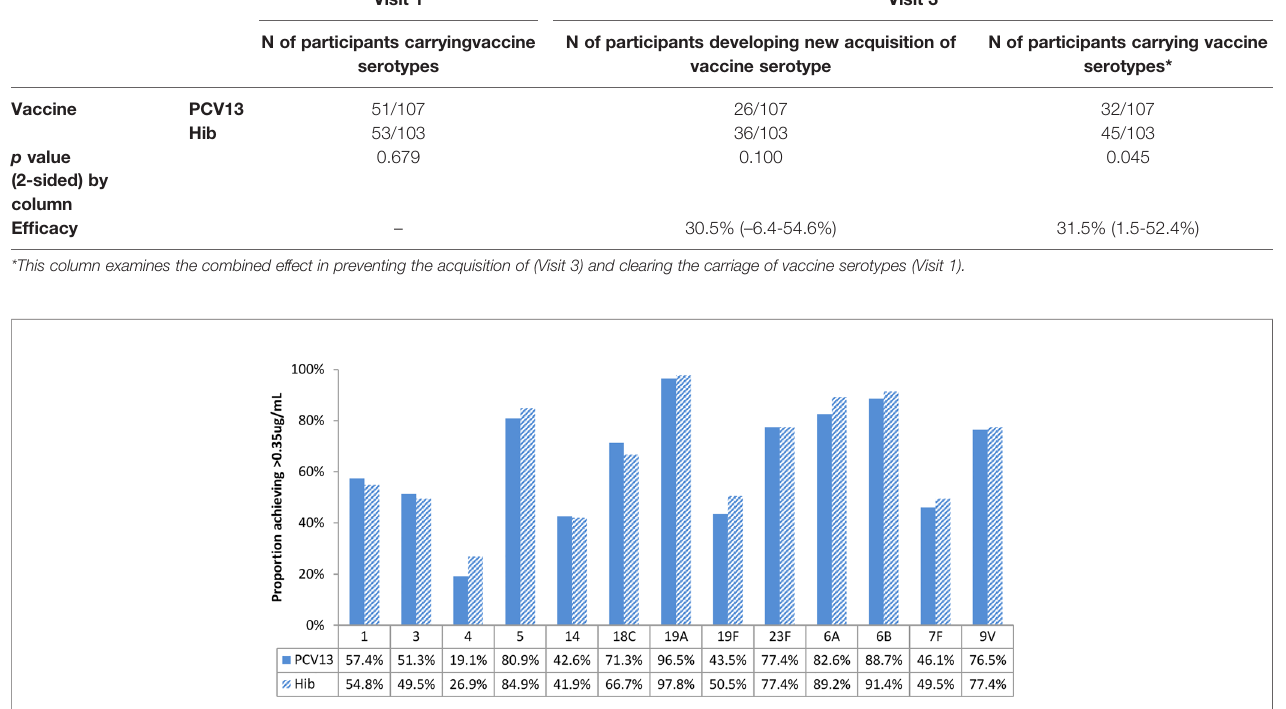
FIGURE 4 | Baseline proportions of participants ’ more than putative protective antibody concentration (0.35ug/mL), by study arms. No statistically signi fi cant differences were found for all vaccine serotypes.